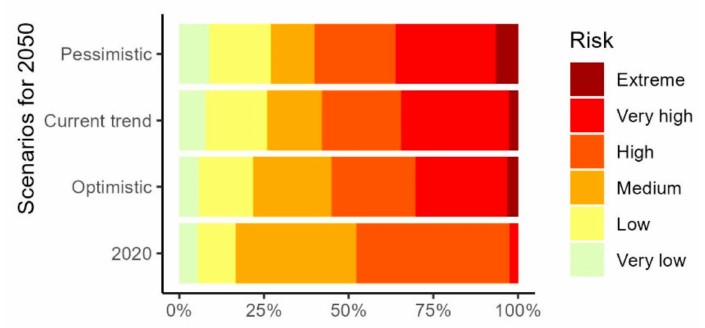
Figure 9. Proportion of projected hydropower projects in different risk classes for flood risk currently (2020) and in 2050 under three scenario pathways: optimistic, current trend, and